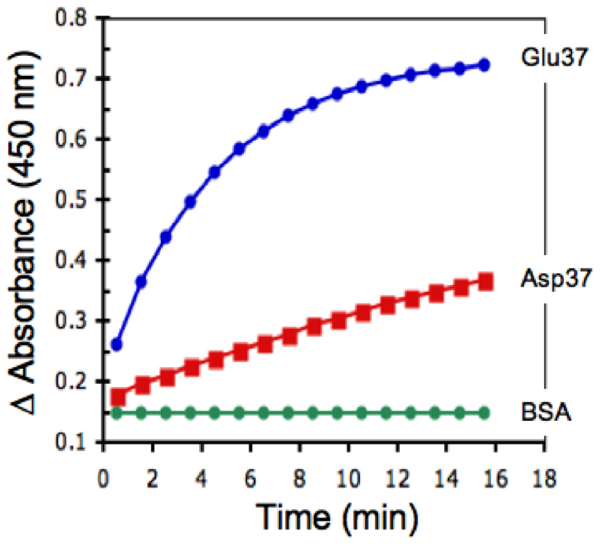
Figure 3. Calculated kinetics parameters: Glu37= 34.1 6 4.0 m M; Asp37 = 820 6 115.1 m M, p , 0.000001, n = 3; Vmax : Glu37 = 58.3 6 1.1 nmol/min/mg; Asp37=25.4 6 1.6 nmol/min/mg, p , 0.0001, n=3; Km: substrate concentration required to reach K maximal velocity; Vmax: maximal velocity; V= velocity.